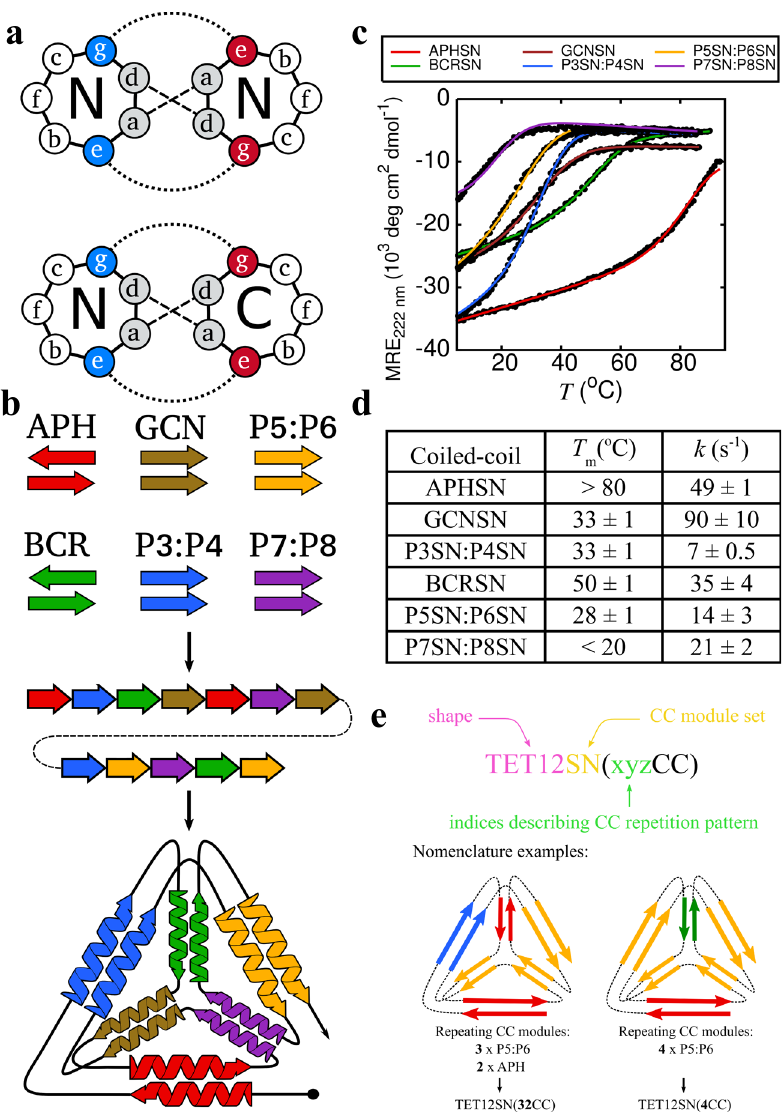
Fig. 1 Coiled-coil protein origami (CCPO) design strategy. a Helical wheel representation of interactions in parallel (above) and antiparallel coiled-coil (CC) dimers (below). b CCPO design strategy relies on covalently linking orthogonal CC dimer-forming peptides into a single polypeptide chain that folds into a polyhedral cage with CC dimers representing its edges. c Temperature unfolding curves for CC building modules comprising TET12SN. Melting temperatures were determined at 40 μ M dimer concentration. d Melting temperatures ( T m ) and rates of refolding ( k ) for CC building blocks. Initial concentrations of peptide dimers for stopped- fl ow experiments were 20 μ M, resulting in 4 μ M concentration post mixing. e Depiction of the naming convention applied to tetrahedral cage designs with repeated CC modules. CCPO cages are named according to the polyhedral shape they resemble (TET12), set of CC building blocks used for their construction (SN 10 ) and the CC repetition pattern. Source data are provided as a Source Data fi